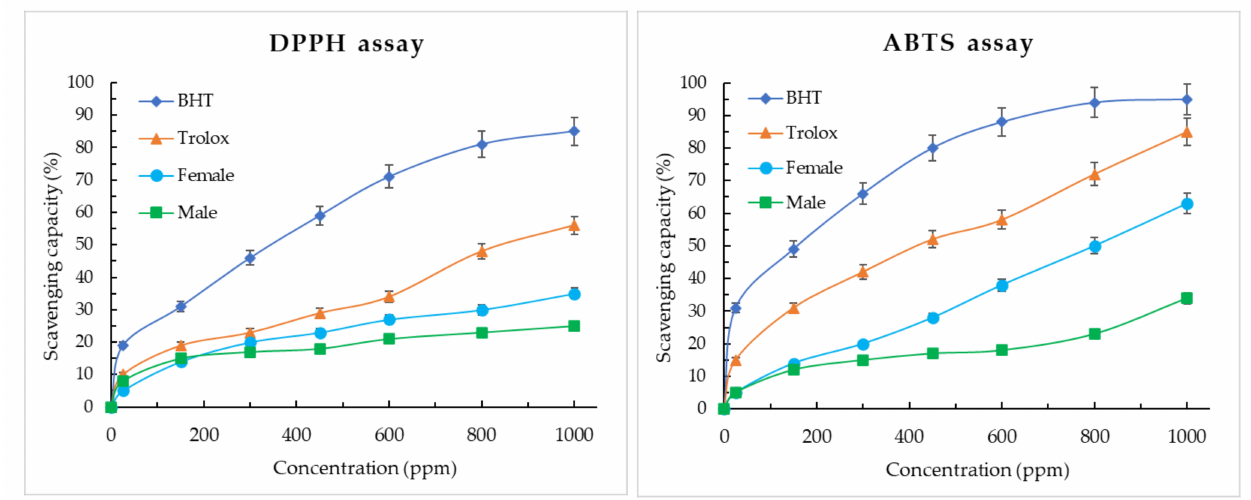
Figure 4. Antioxidant activity of Hedyosmum racemosum leaves essential oil.